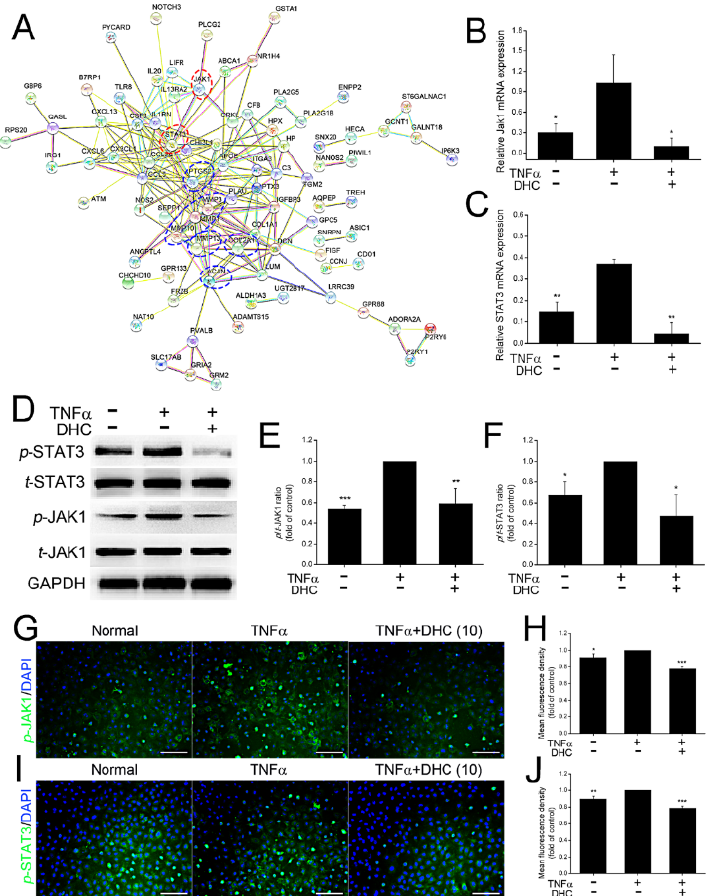
Figure 4. Dehydrocorydaline (DHC) inhibited the mRNA and phosphorylated JAK1 and STAT3 expression in the TNF α -treated human chondrocytes. ( A ) Protein interaction network analysis of the common differently expressed genes (DEGs). ( B ) JAK1 and ( C ) STAT3 mRNA expression levels in the human chondrocytes in the normal, TNF α and TNF α + 10 µ M DHC groups. ( D ) Western blotting analysis and the quantified results of phosphorylated/total ( p / t ) ratio of ( E ) JAK1 and ( F ) STST3. ( G ) Immunofluorescence staining of p -JAK1 and ( H ) quantified results. ( I ) Immunofluorescence staining of p-STAT3 and ( J ) quantified results. Scale bar = 100 µ m. Data are presented as mean ±